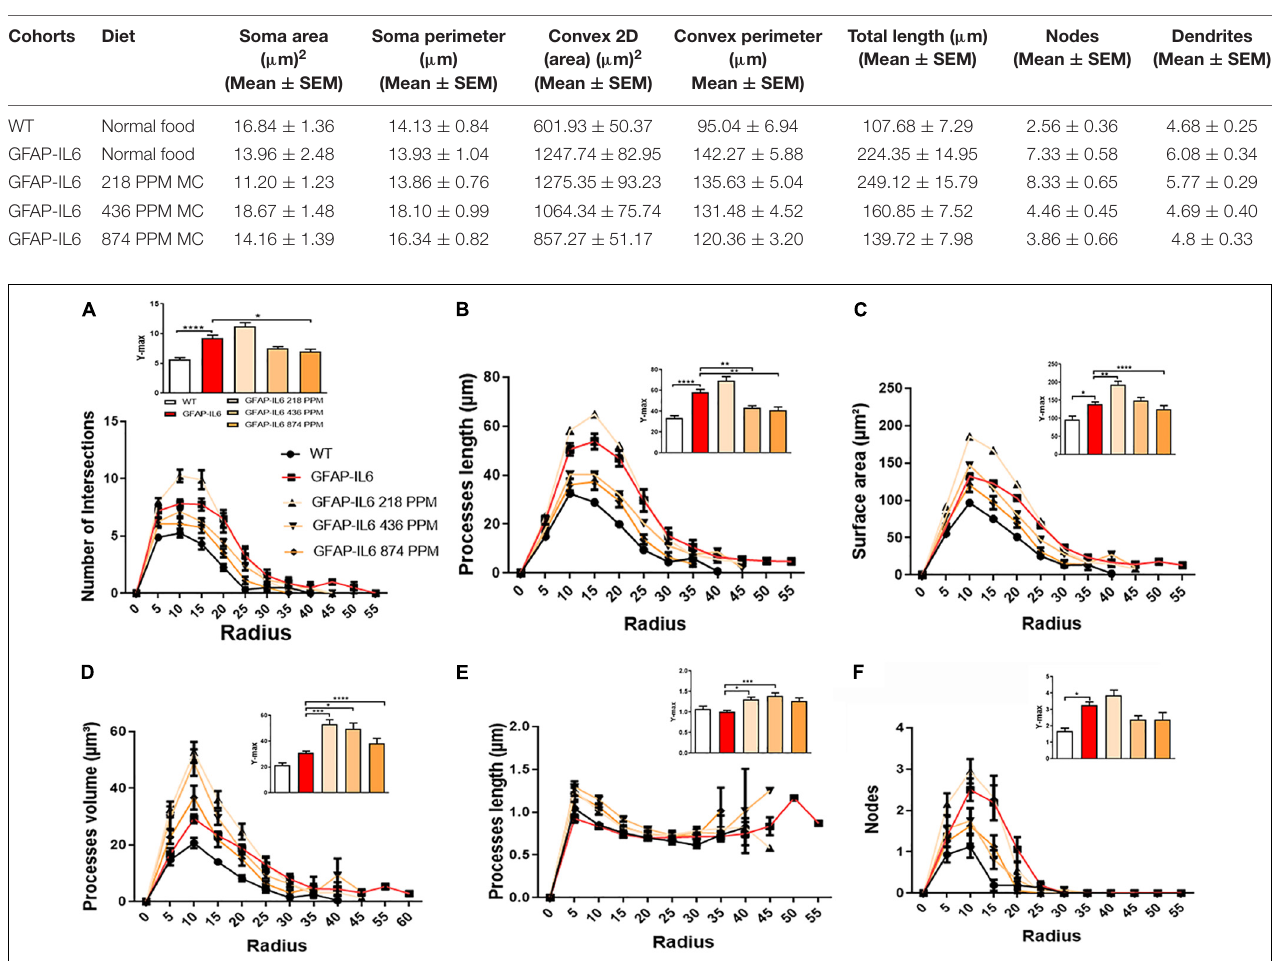
TABLE 6 | Morphological analysis of GFAP + astrocytes in the hippocampus.